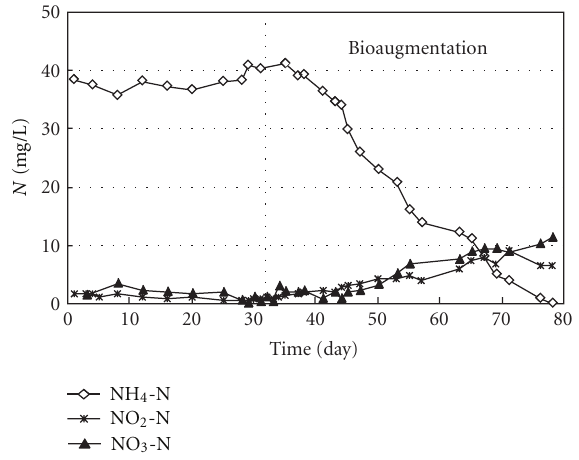
Figure 2: E ffl uent profiles of main-stream reactor.